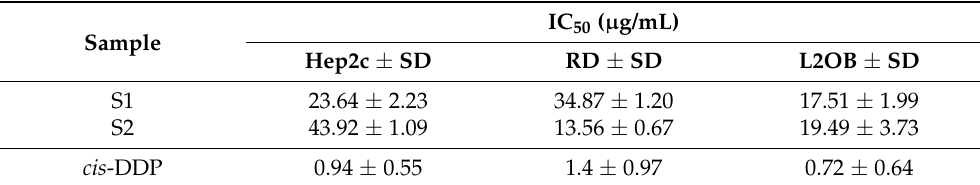
Table 4. Cytotoxic activity of Sideritis sipylea essential oil extracted from wild-growing Greek material (S1: mid-summer collection, Samos Island; S2: early summer collection, Lesvos Island) in one murine (L2OB) and two human cell lines (Hep2c, RD) compared to the standard cytotoxic agent cis -diammine dichloroplatinum ( cis-